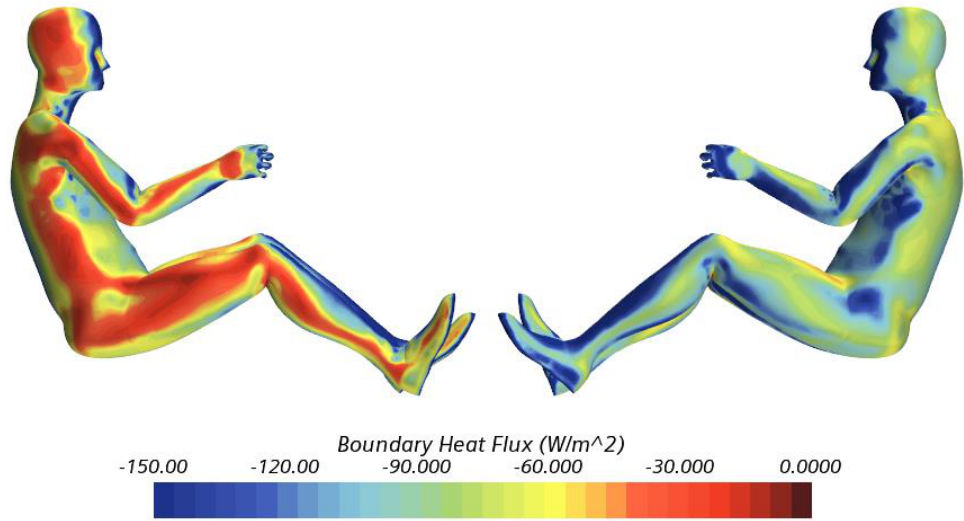
Figure 15. Total heat flux at the manikin at 25 °C inlet temperature.